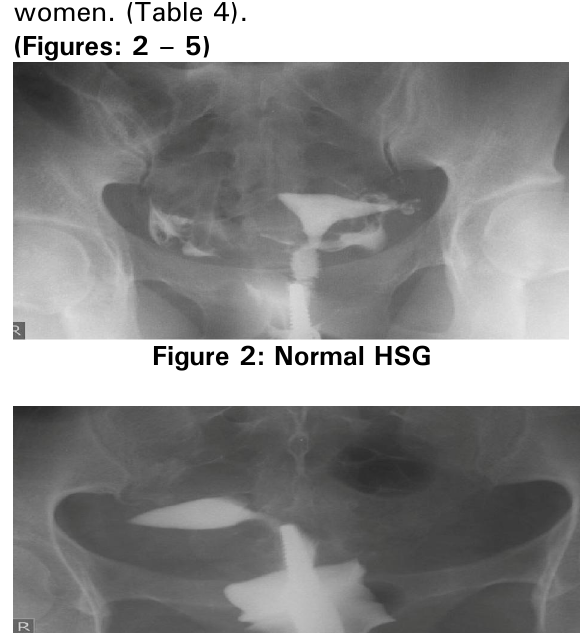
Figure 3: B/L tubal block